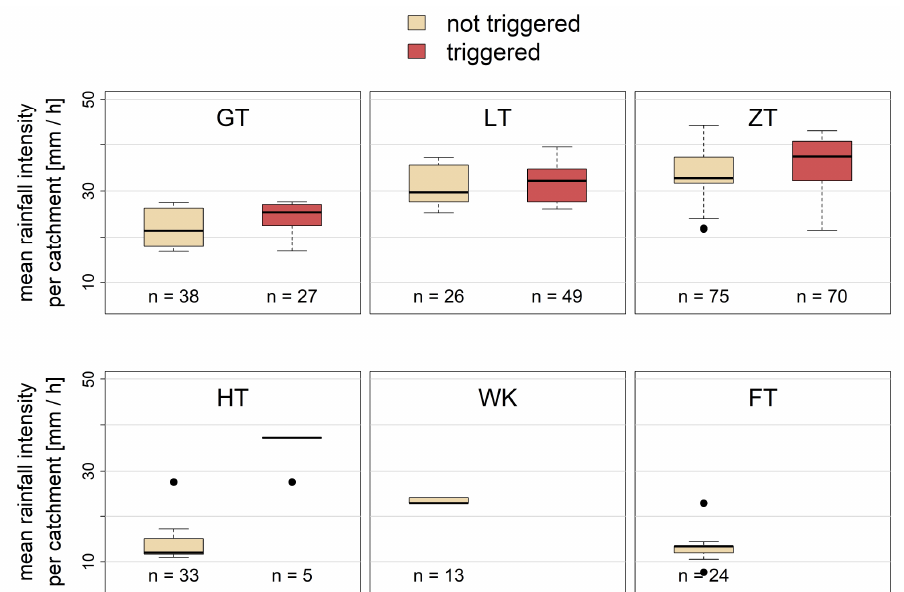
Figure 14. Comparison of the mean rainfall intensity for each debris flow catchment during the rainfall event on 20 July 2022 divided into the different sub-catchments.